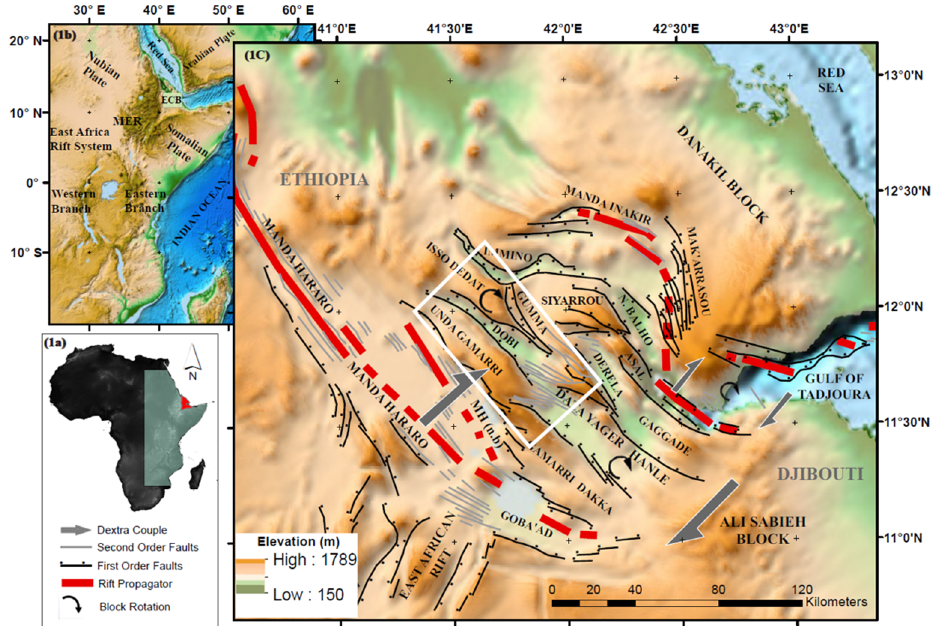
Figure 1. ( A ) Digital elevation model of Africa. The mint-colored area represents the region affected by the East Africa Rift System, and the small red polygon in the Horn of Africa represents the Afar Depression; ( B ) The EARS. The northern tip is the AD comprised by the East Central Block (ECB) in the center. The eastern and the western branch of the EARS exist south of MER; ( C ) Tectonic framework of the Afar Depression (AD) shown in Shuttle Radar Topographic Mission (SRTM) digital elevation model (DEM). The white rectangle is a polygonal inset of the study area that includes the Dobi graben and its associated tectonic settings. Solid red lines indicate major rift propagators, mainly the Red Sea Rift (RSR) and Gulf of Aden Rift (GAR). The element of rifts’ and blocks’ structures in the AD are represented by black lines and second-order faults with gray lines [2]. Clockwise rotation of the NW-trending blocks [3] are displayed with black curve arrow lines, and both NE- and SW-directed, dextral, strike-slip shear-couples are indicated with broad gray colored arrow lines.